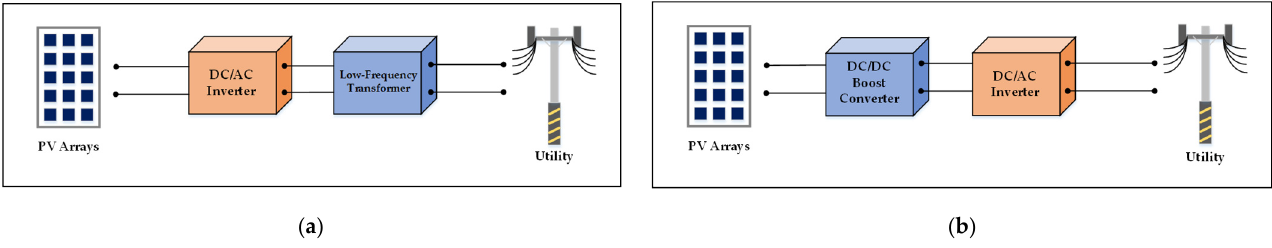
Figure 1. The structures of PV grid-connected power systems with ( a ) a low-frequency transformer; ( b ) a boost converter.